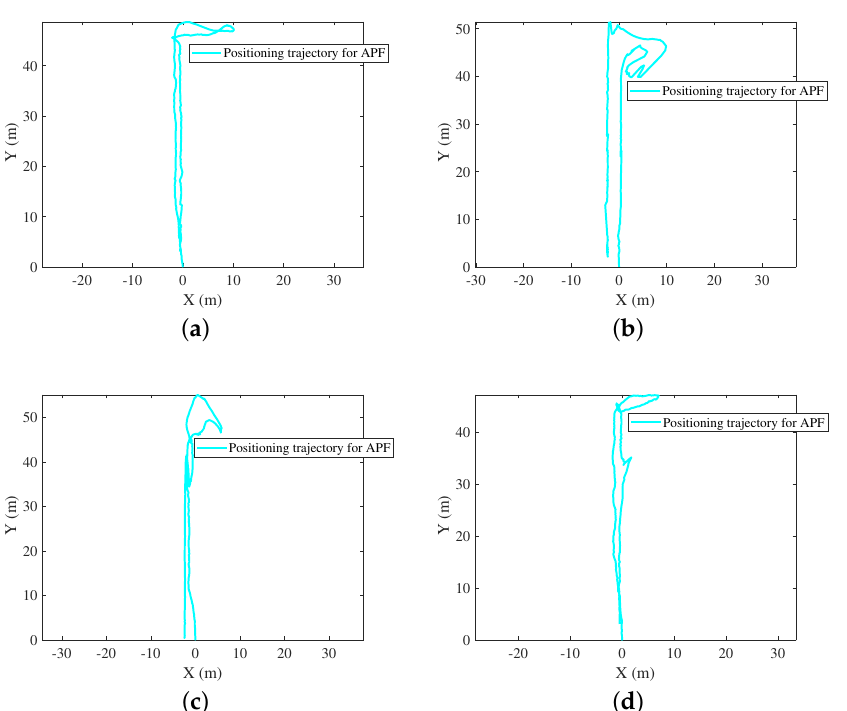
Figure 11. Navigation trajectories for APF. ( a ) Calling mode. ( b ) Dangling mode. ( c ) Handheld mode. ( d ) Pocketed mode.